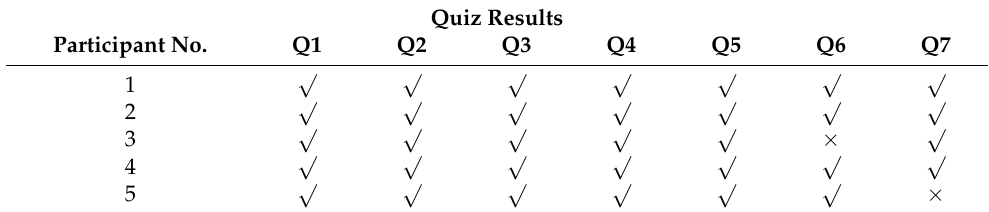
Table 2. Summary of the quiz